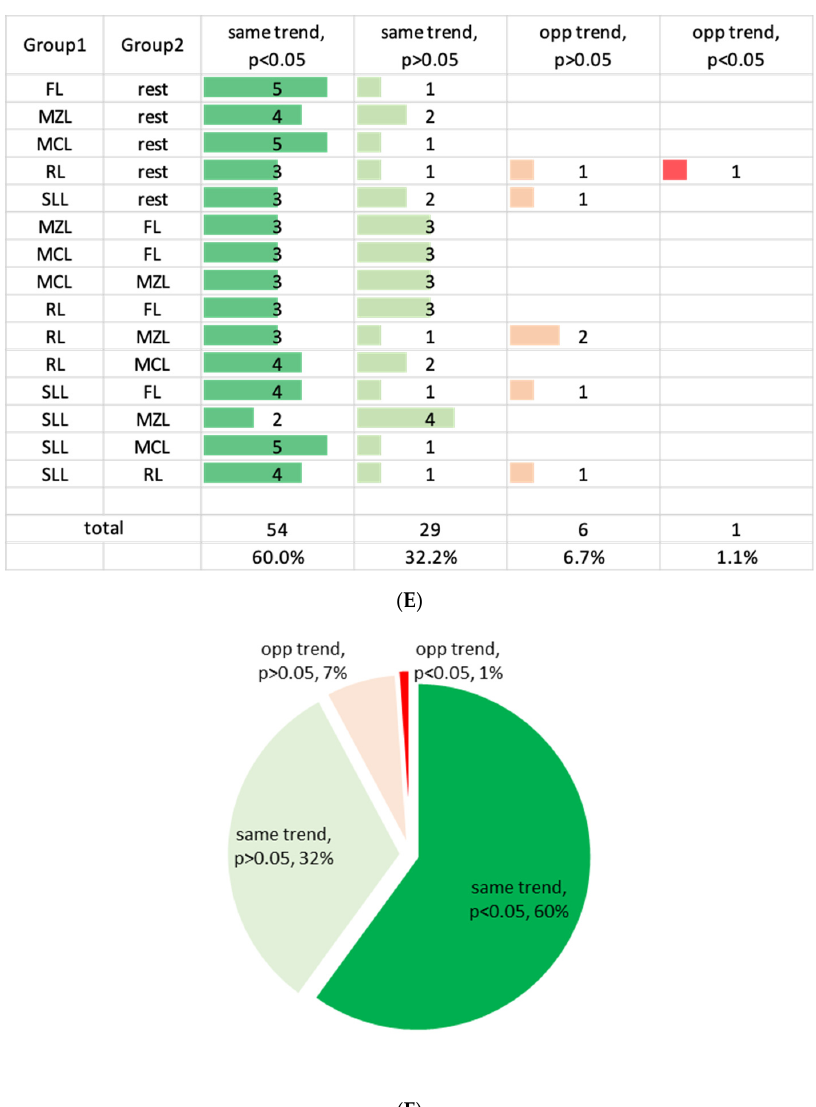
Figure 2. Distinct lymphoma subtypes can be distinguished by miRNA expression profiles in both discovery and validation cohorts. Heatmap showing hierarchical clustering of FFPE samples of 5 different subtypes in the discovery cohort ( A ) and validation cohort ( B ) based on the expression of 90 candidate miRNAs. Principal component analysis of miRNA expression profiles of FFPE samples in the discovery ( C ) and validation ( D ) cohort. ( E ) Comparison of the expression changes of the 90 candidate miRNAs between the discovery and validation cohorts. ( F ) Numbers of miRNAs showing consistent or inconsistent changes between discovery and validation cohorts. Abbreviations: SLL, small lymphocytic lymphoma/chronic lymphocytic leukemia; CLL, chronic lymphocytic leukemia; FL, low-grade follicular lymphoma; MCL, mantle cell lymphoma; MZL, marginal zone lymphoma; RL, reactive lymphoid proliferations.